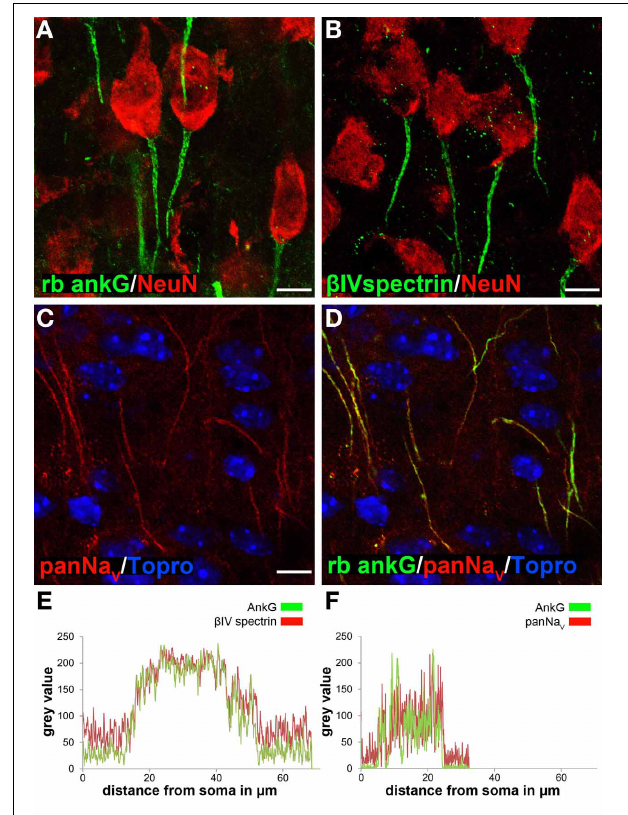
FIGURE 1 | Ankyrin-G as a reliable marker for AIS length analysis in cortical neurons. AIS were specifically stained using various markers. (A) AnkG (green) and NeuN (red) in layer II/III neurons in a P35 animal. (B) β IV spectrin (green) and NeuN (red) in layer II/III neurons in a P35 animal. (C) PanNa V (red) in layer II/III neurons in a P15 animal. (D) Merged image of C and ankG (green) with TO-PRO © -3 (blue) as nuclear stain, showing complete overlap of ankG and panNa V signals. (E) Fluorescence intensity profile for AIS markers ankG (green) and β IV spectrin (red) in an example of a long AIS in a P15 animal, indicating signal overlap for the same AIS distance from the soma. (F) Fluorescence intensity profile for ankG (green) and panNa V (red), here in an example of a short AIS (P15). Again, signals overlapped with both markers. Scale bars (A–D) = 20 μ